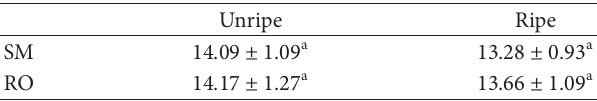
Table 1: Total phenolic content of the aqueous extract of Capsicum spp. (mg/g